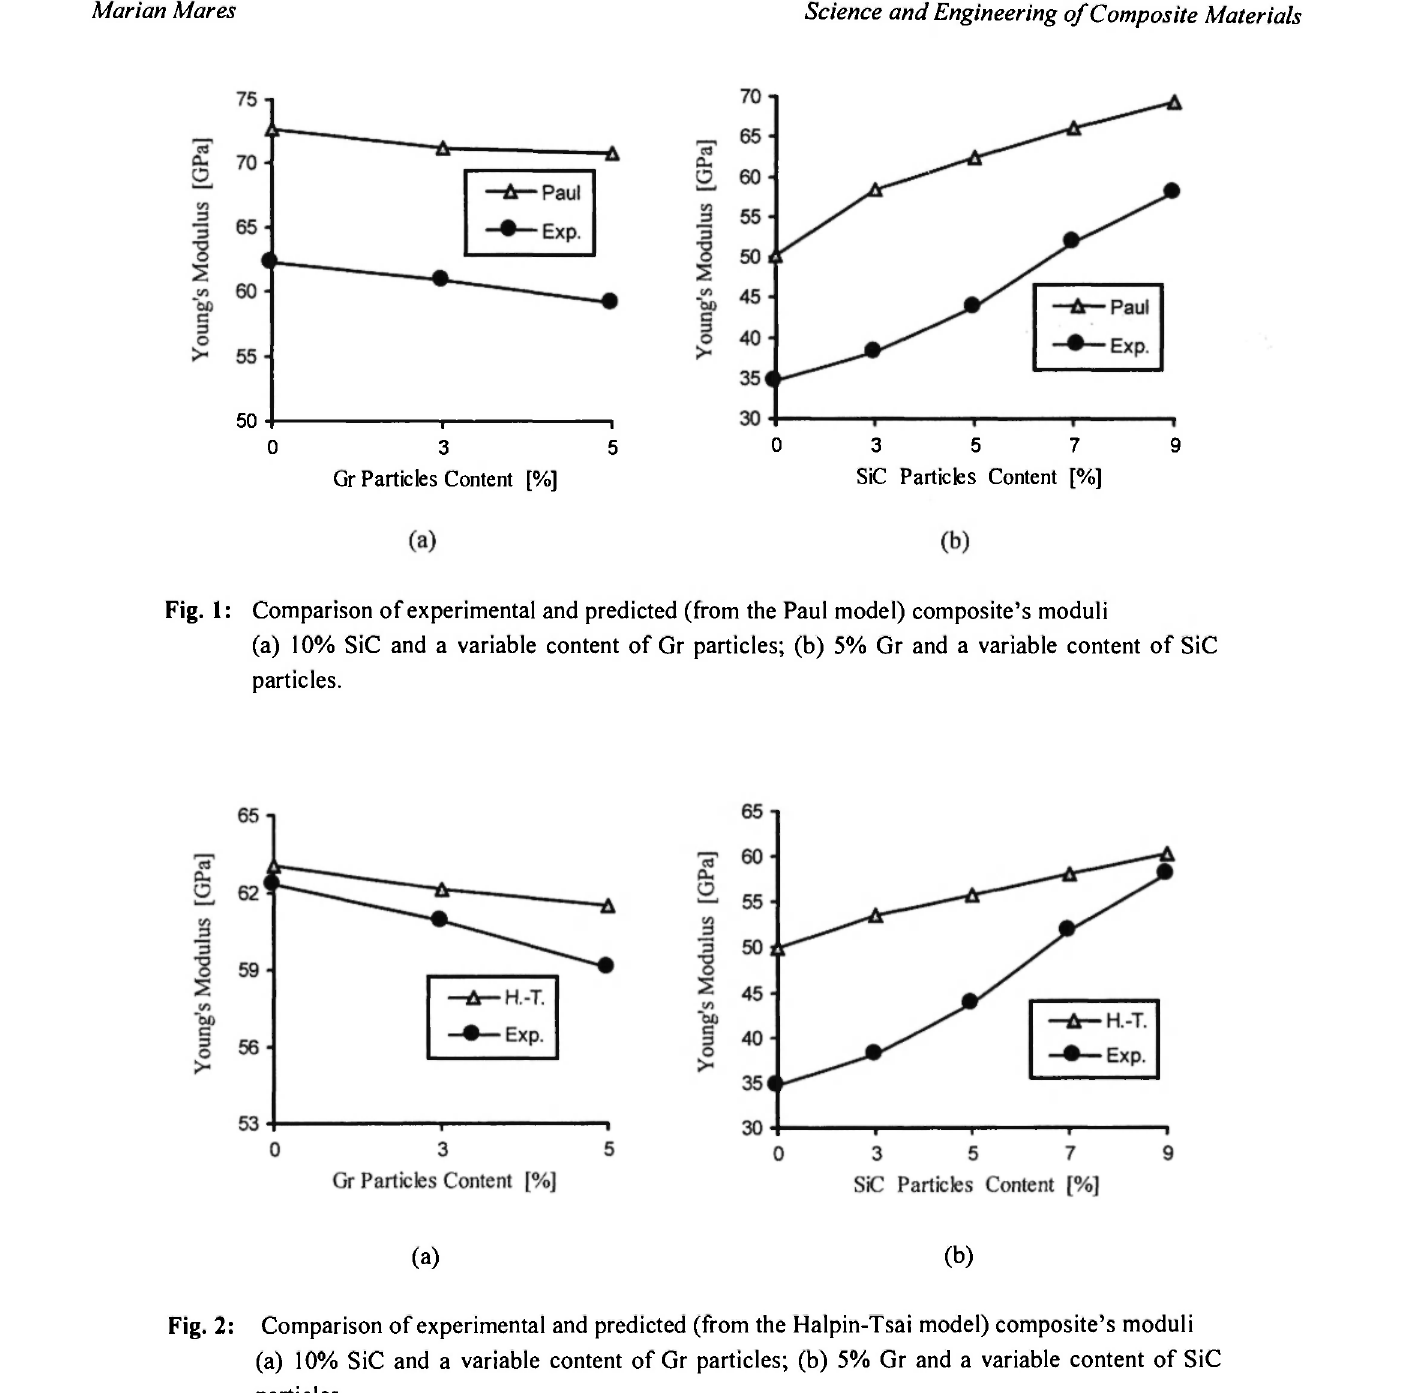
Fig. 2: Comparison of experimental and predicted (from the Halpin-Tsai model) composite's moduli (a) 10% SiC and a variable content of Gr particles; (b) 5% Gr and a variable content of SiC